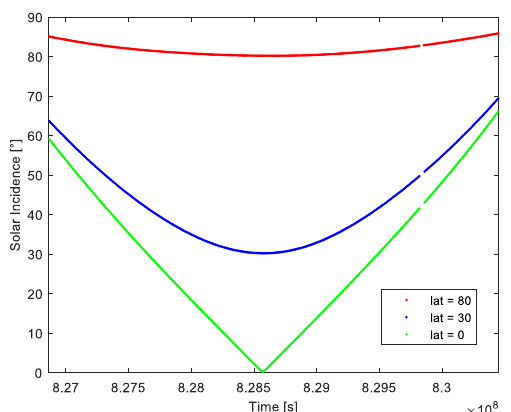
Figure 6. The graph shows the solar incidence in dependence to the Latitude of the target. The simulation is done during one window of time for high resolution acquisition (15 mar 2026 – 26 apr